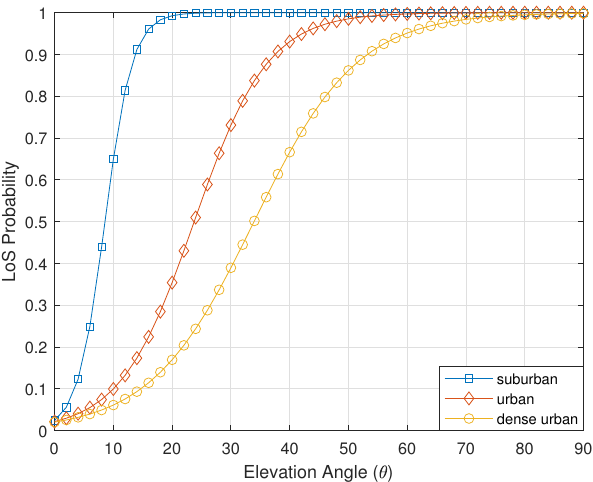
Figure 3. LoS probability versus the elevation angle for different urban